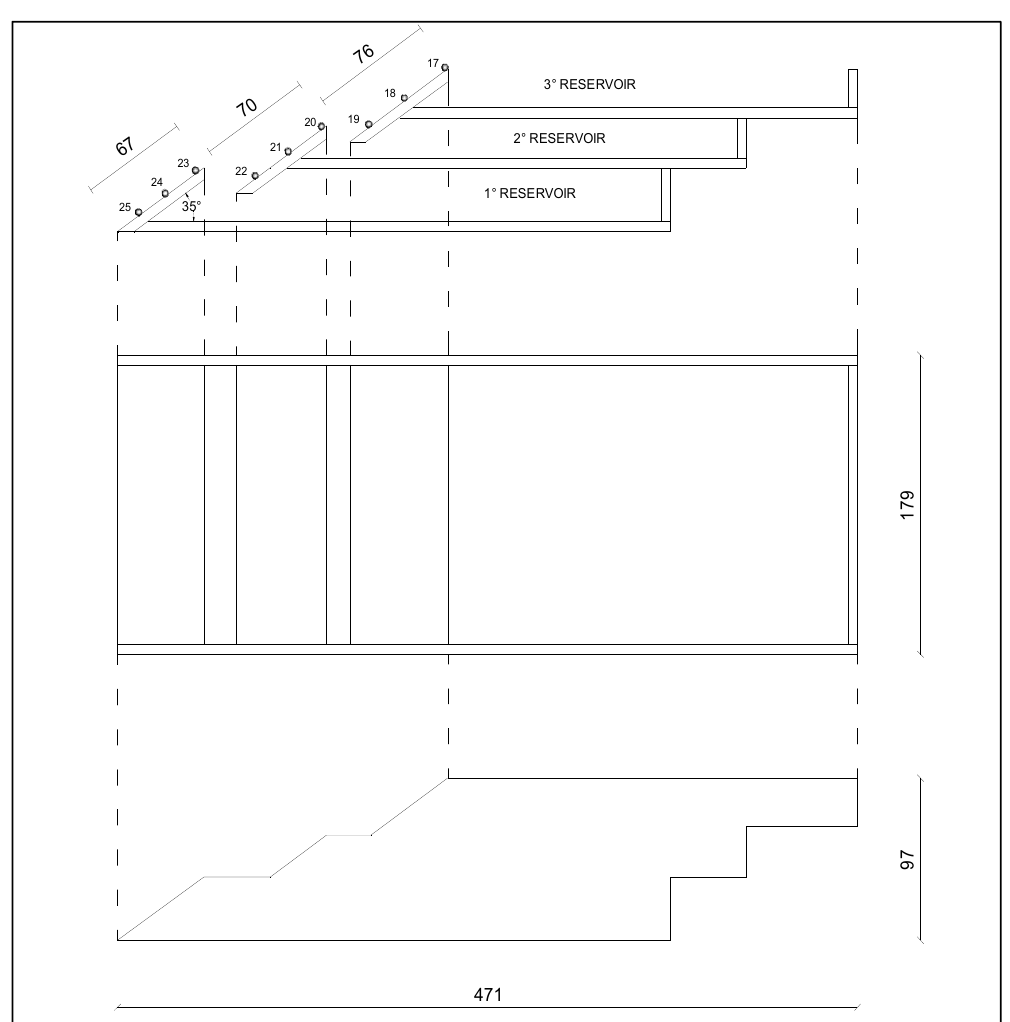
Figure 4. Sketch of the SSG model (dimensions are in